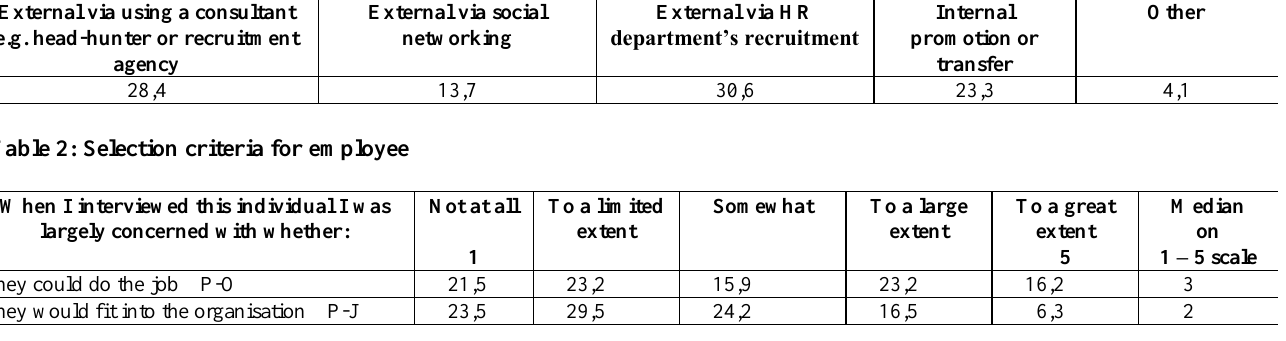
Table 1: Source of new appointee External via using a consultant e.g. head-hunter or recruitment